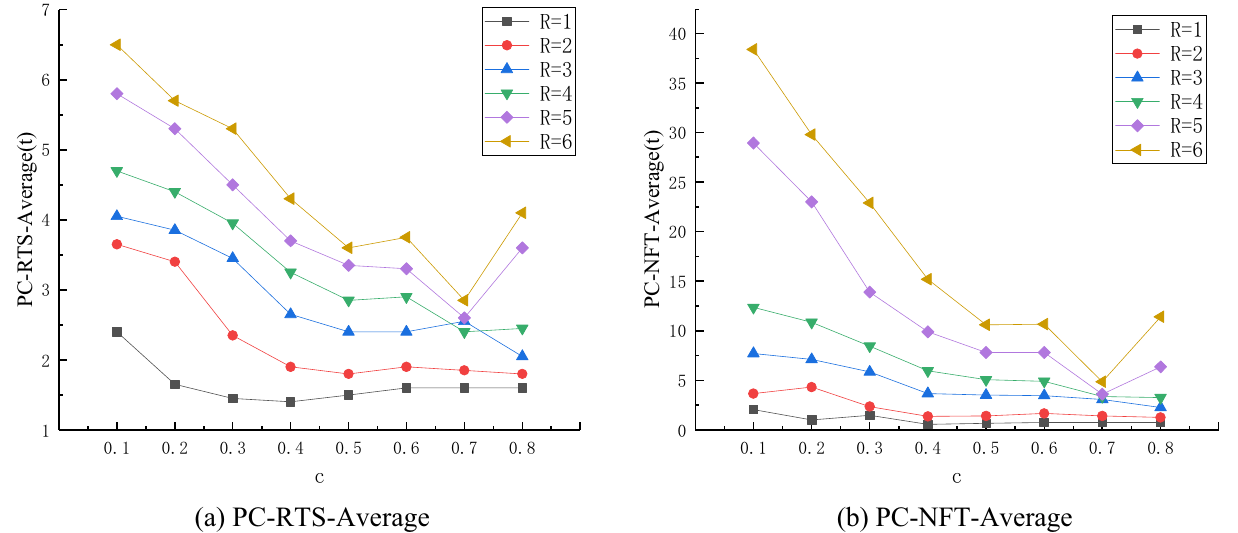
Figure 3. Variation relationship between different R and c values at control node